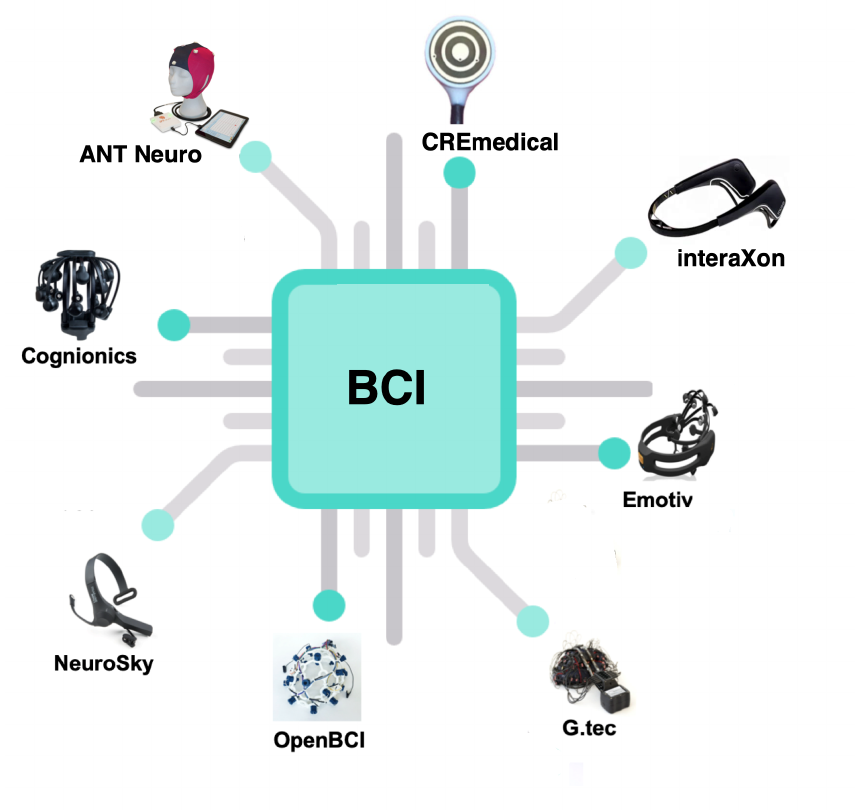
Figure 5. The most popular inexpensive, customer-grade EEG headsets from the Table 3 (based on